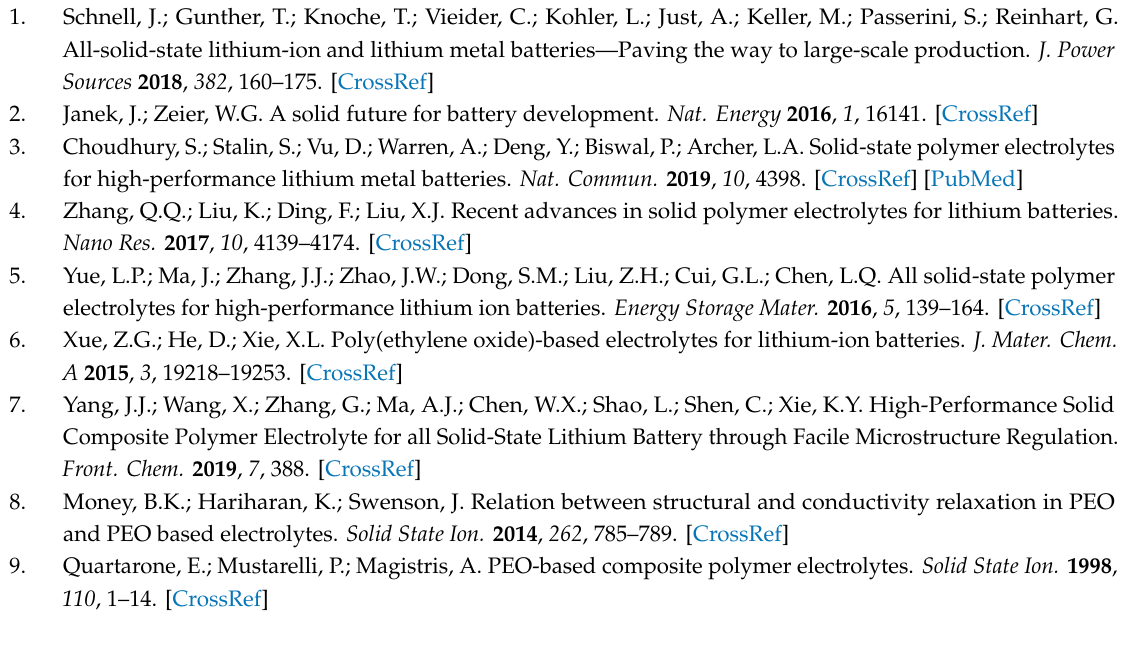
Table S1: Material properties of the constituents of LiCoO 2 cathode